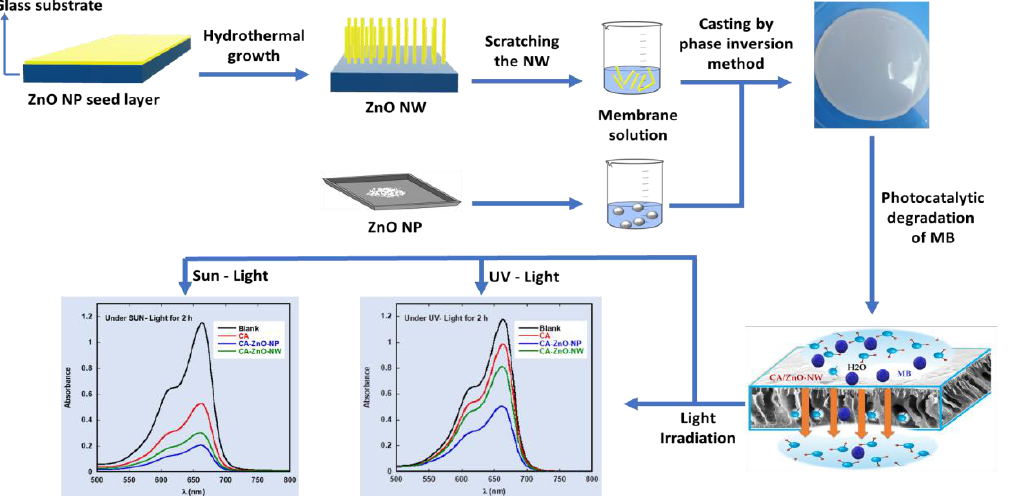
Figure 1. Schematic illustration of CA-ZnO-nanostructured membrane preparation and testing processes.